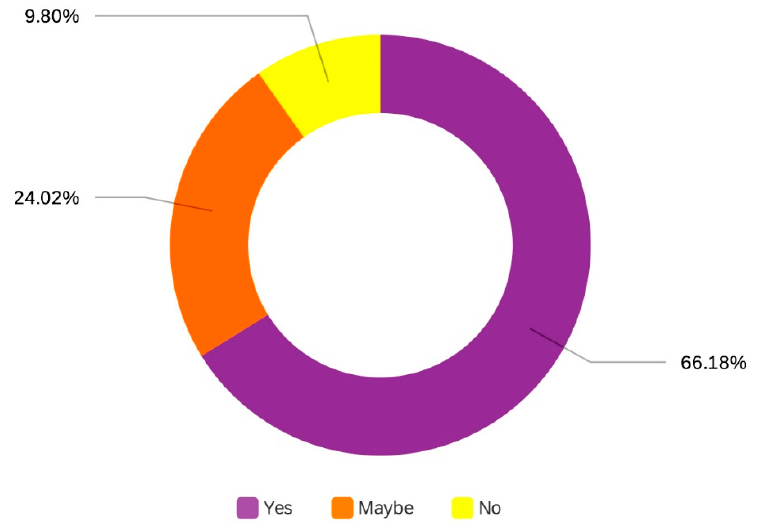
Figure 4. Level of respondents’ knowledge about the permanent forest reserve system in Malaysia. Table 4. Levels of knowledge about permanent reserved forests by